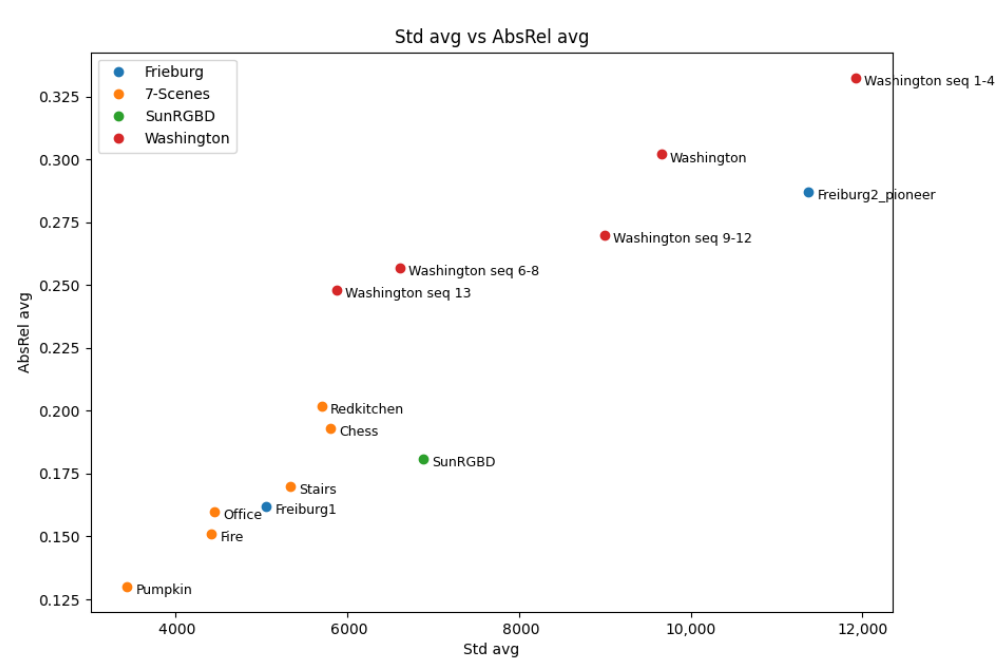
Figure 10. Averag standard deviation σ 2 vs. mean absolute relative error for every